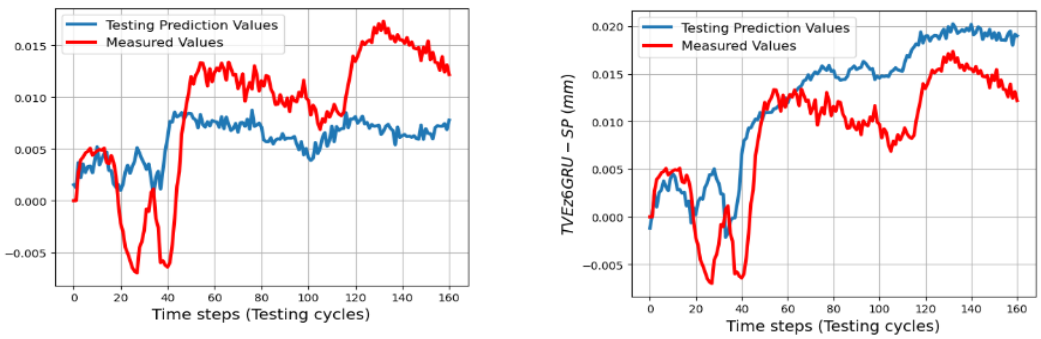
Figure 28. Prediction of TVEz6 by SLSTMs and SGRUs in the short process (SP) (1 cycle = 15 min).